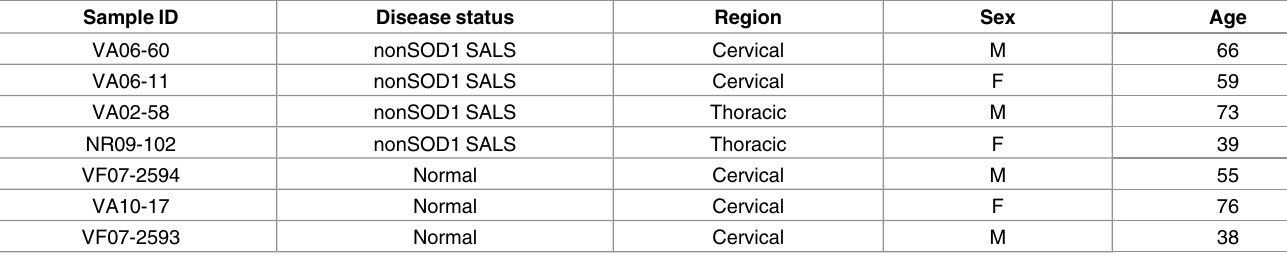
Table 2. ALS patient and Normal Human post mortem spinal cord